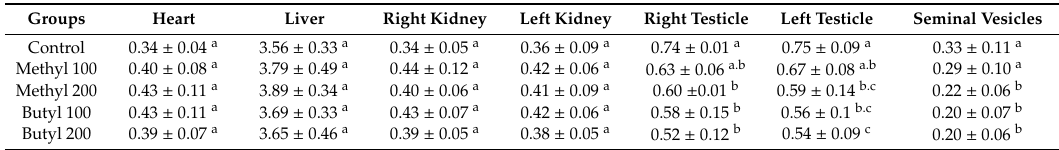
Table 1. Relative mass (g) of di ff erent organs of animals (mean (M) ± standard deviation (SD)) of di ff erent groups. The relative organ weights (organ weight / animal weight) in percentage. The results with di ff erent letters mean they are statistically di ff erent from each other ( p < 0.05).